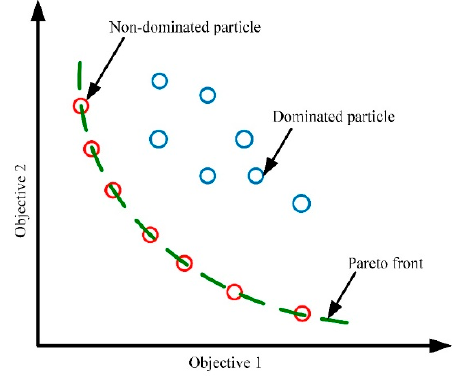
Figure 6. Pareto front (PF) plot [42].